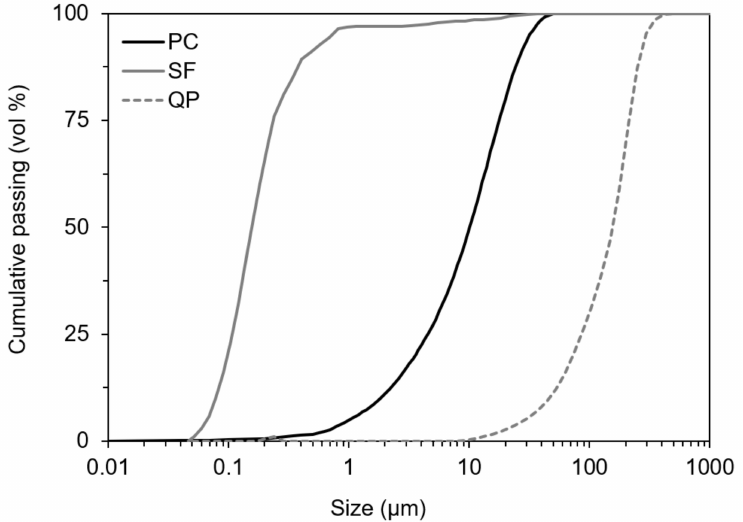
Figure 1. Particle size distribution (PSD) of the Portland cement (PC), silica fume (SF), and quartz powder (QP)